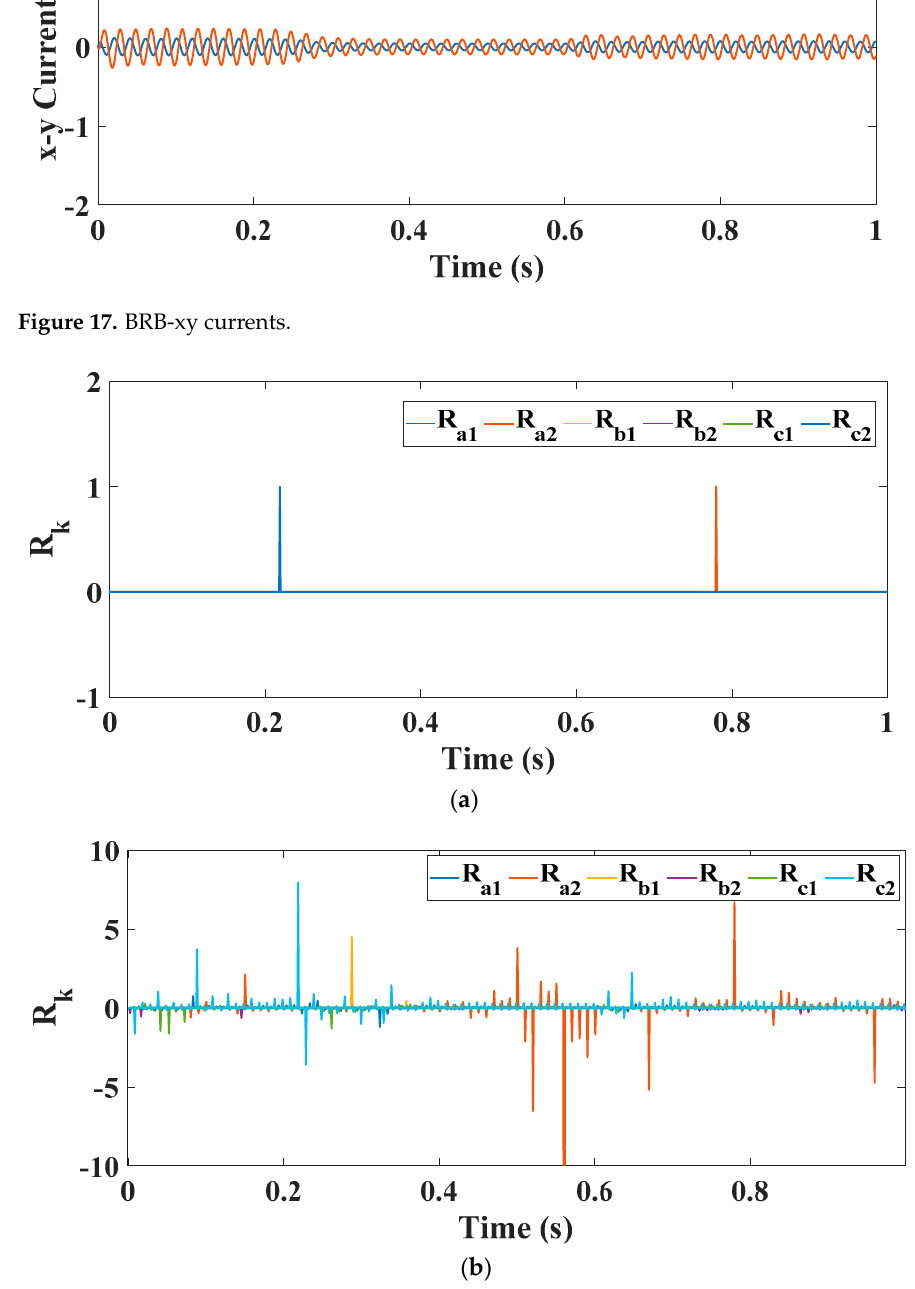
Figure 18. ( a ) Filtered indices; ( b ) Unfiltered indices.